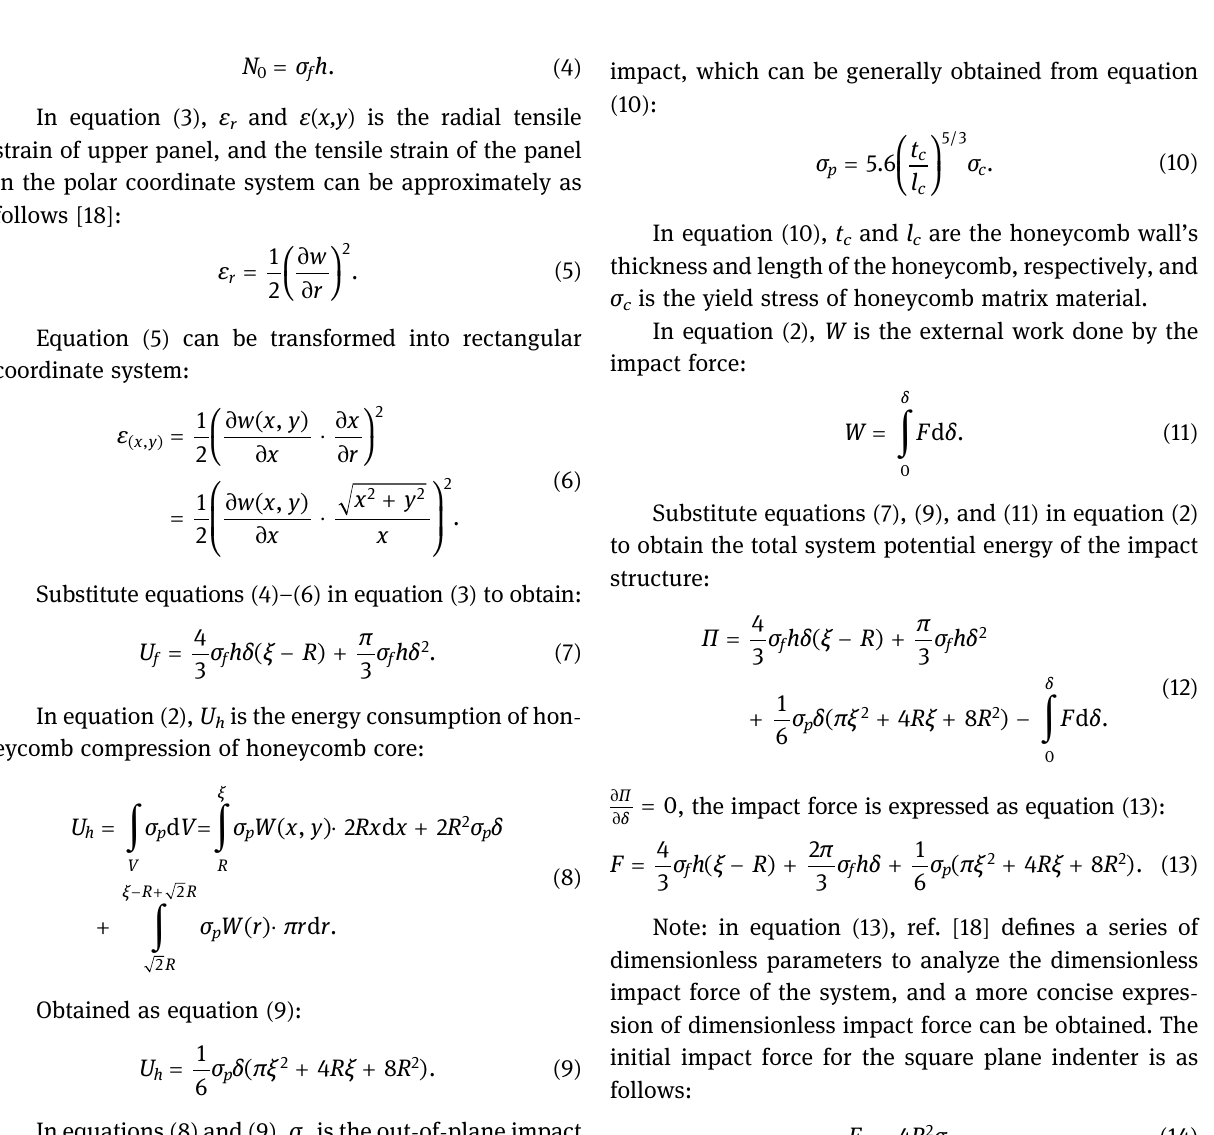
Figure 7: Schematic pro fi le of the deforming zone under a square fl at indenter. ( a ) Schematic diagram of B and A. ( b ) Schematic diagram of B and